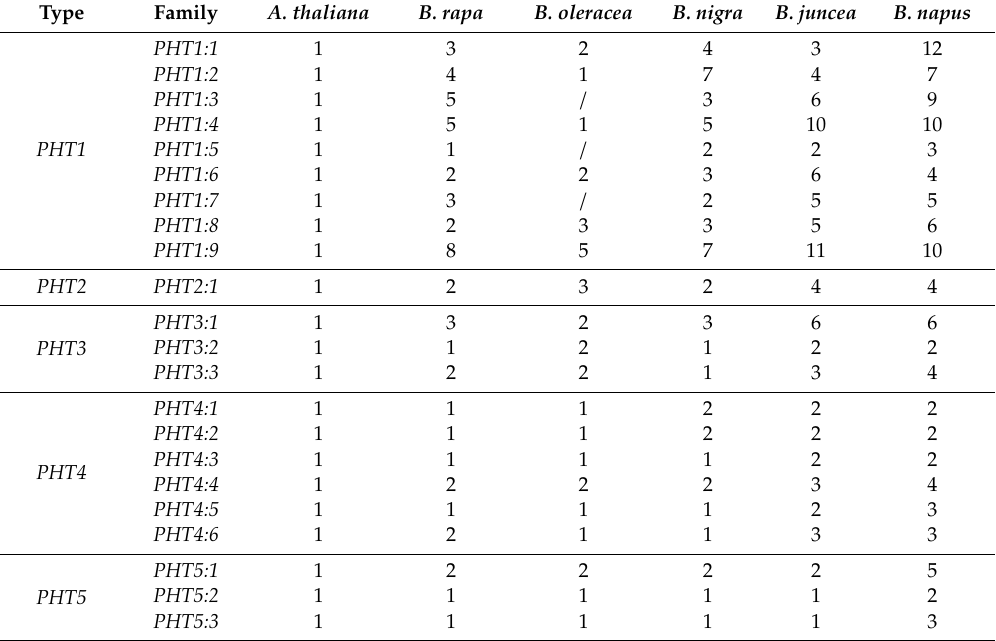
Table 1. Statistics of PHT genes in each PHT subroup between Arabidopsis thaliana and five Brassica